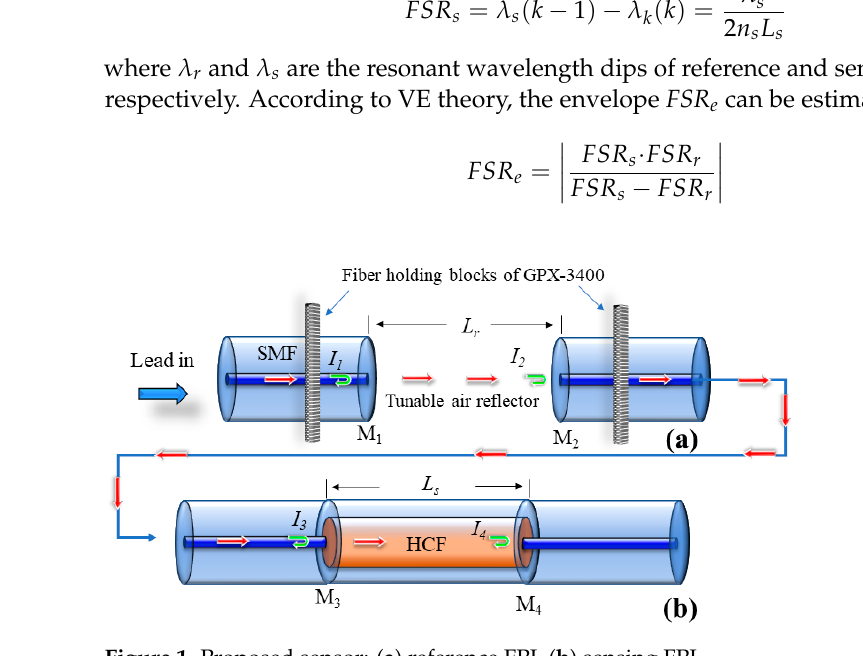
Figure 1. Proposed sensor: ( a ) reference FPI, ( b ) sensing